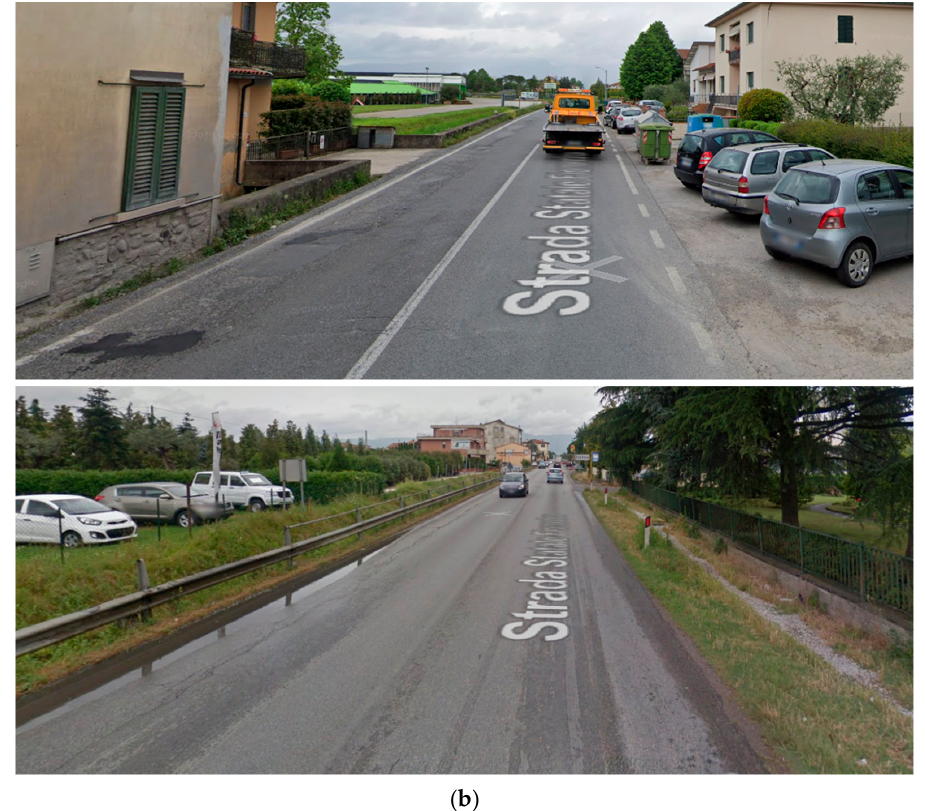
Figure A10 . 2nd Case study, Road SR66_Sud: ( a ) in 2008, ( b ) in 2019.